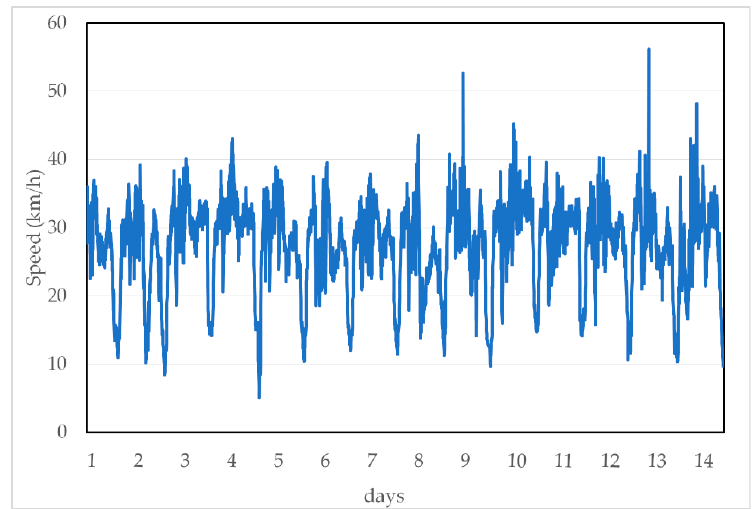
Figure 4. Traffic speed patterns. Figure 4. Tra ffi c speed patterns.